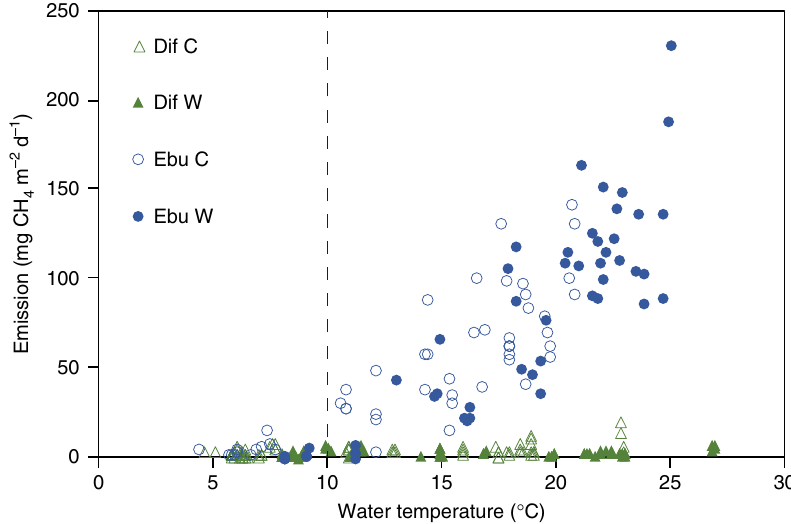
Fig. 3 Diffusive and ebullitive CH 4 emissions expressed against water temperature. Dif refers to diffusive CH 4 emissions and Ebu refers to ebullitive CH 4 emissions. The dashed vertical line represents the onset of strongly increased ebullition and a transition to ebullition-dominated fl ux. Open and closed symbols denote control (C) and warm (W) treatment,